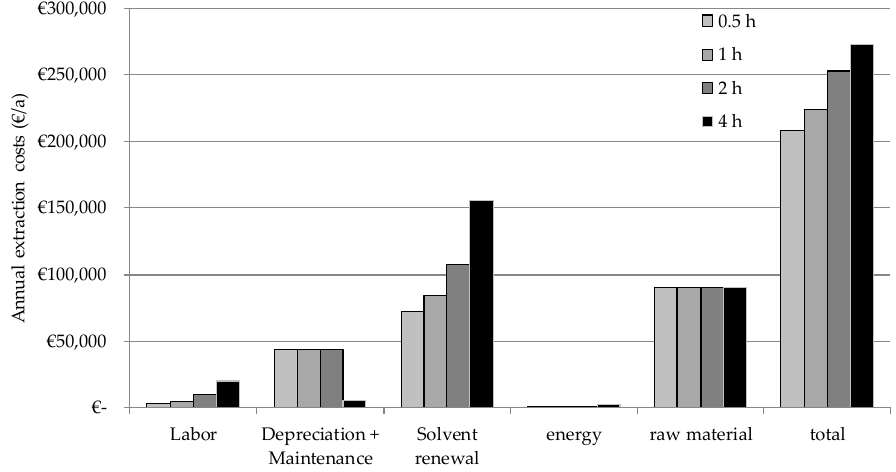
Figure 14. Annual extraction cost reduction by reduced extraction time for Hawthorn.